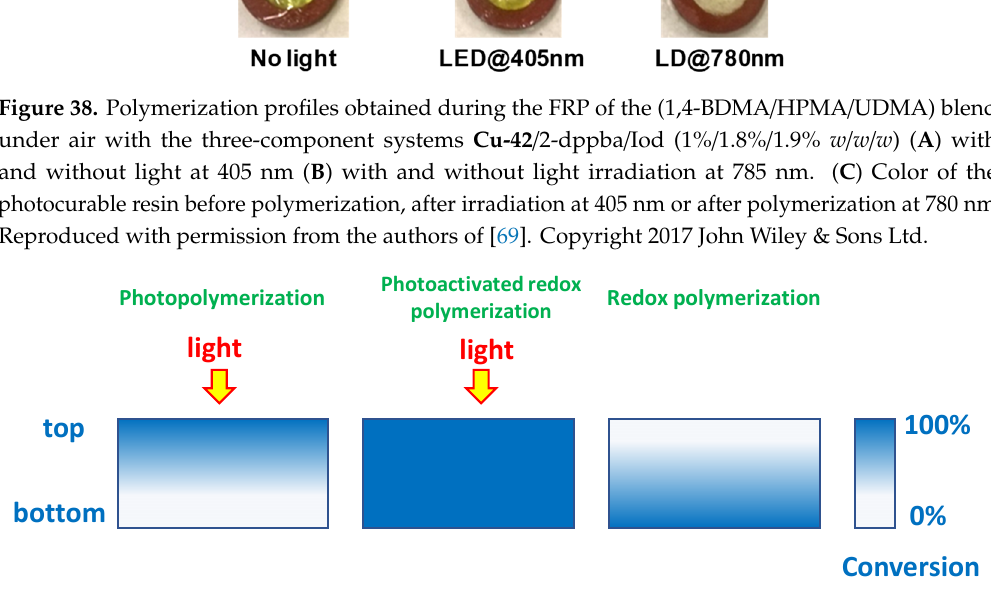
Figure 39. Specificities of photopolymerization, redox, and redox-activated polymerization.